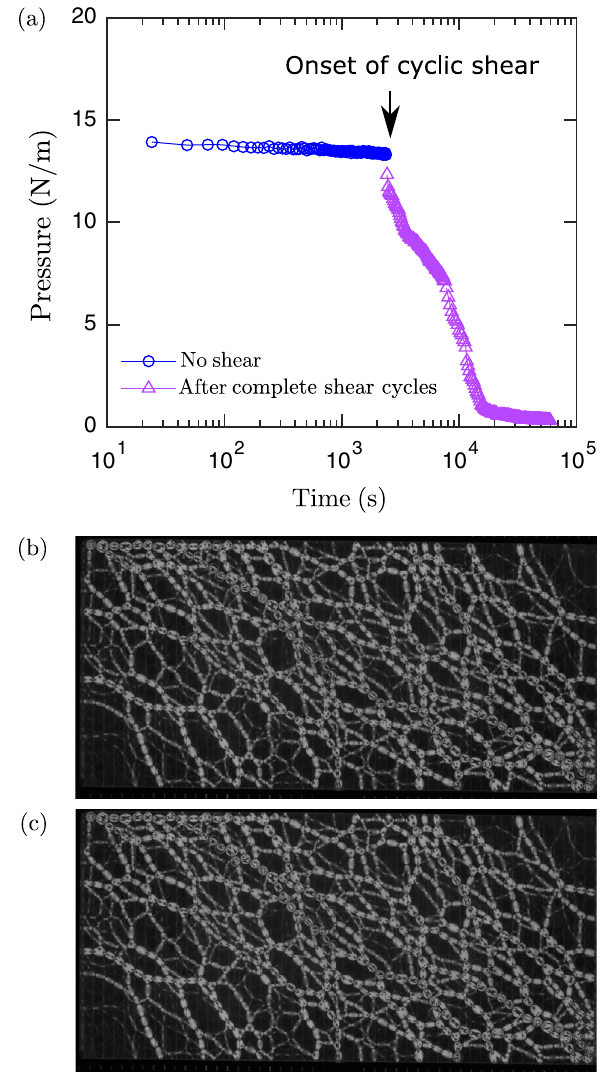
FIG. 12. (a) The pressure evolution of an original shear-jammed ¼ 0 . 126 . From state formed at time 0 s by an initial shear strain γ I 0 to 2376 s, there is no deformation applied to the system, and the pressure is measured per 24 s (blue circles). Starting from 2376 s, we start cycle shear and record pressure after complete shear cycles (purple triangles). (b) and (c) are snapshots of the system at time 0 s and time 2376 s. See Supplemental Video 3 [30] for a video of this relaxation process with an enlarged